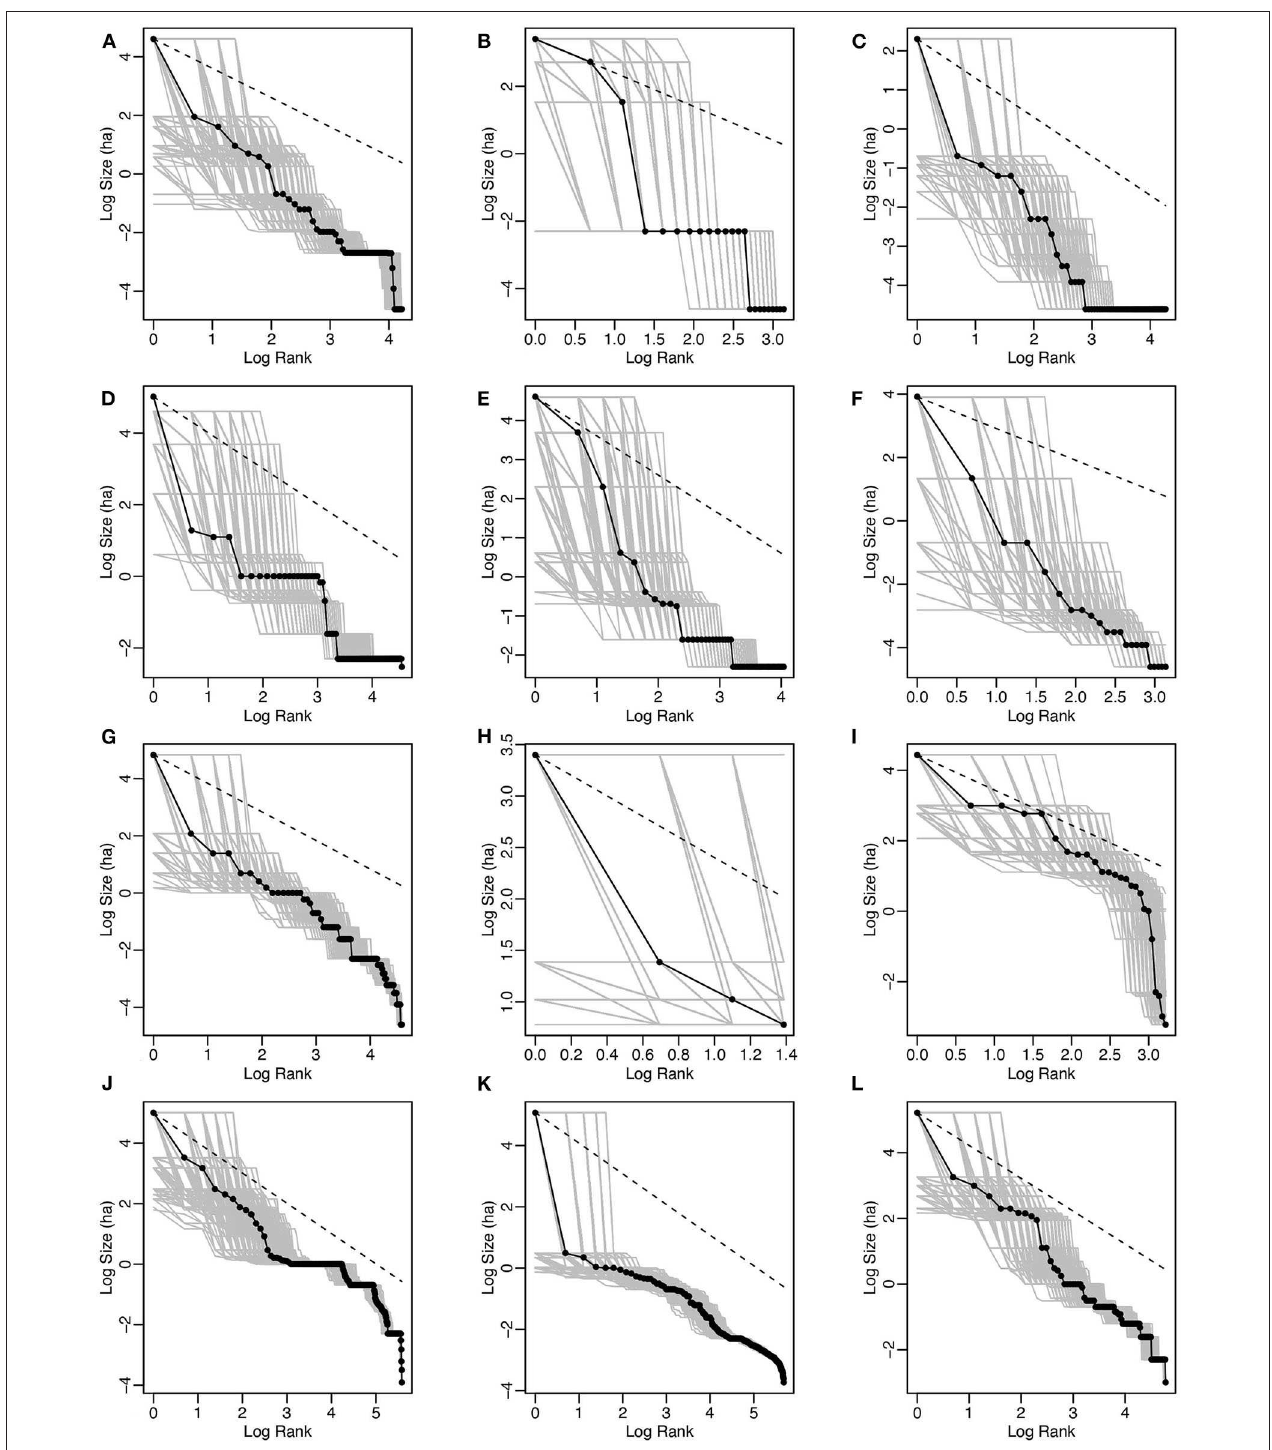
FIGURE 8 | Rank size for the territories of Archaic centres with sufficient data points. (A) Volterra, (B) Fiesole, (C) Murlo, (D) Populonia, (E) Vetulonia, (F) Chiusi, (G) Vulci, (H) Acquarossa, (I) Orvieto, (J) Tarquinia, (K) Cerveteri, (L) Veio. The dark line represents the observed data. The grey lines represent the bootstrap results performed on random samples of